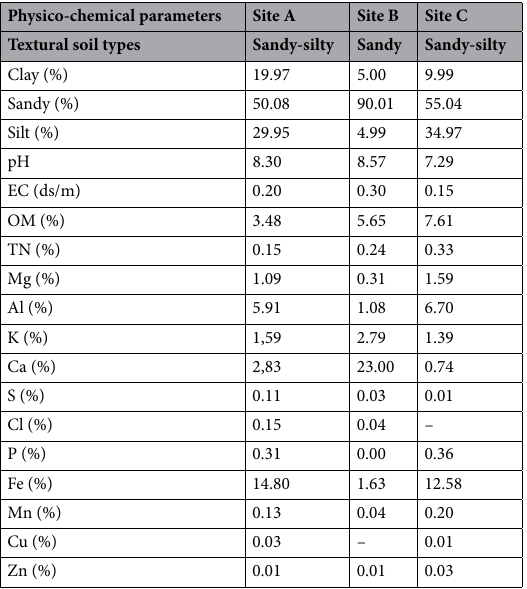
Table 1. Physico-chemical analysis of soil samples. Site A (Sebt Jahjouh El Hajeb); Site B (Forest of Ain Vittel Ifrane); Site C (Forest of Azrou); (–) not detectable, EC electrical conductivity, OM organic matter, TN total nitrogen.